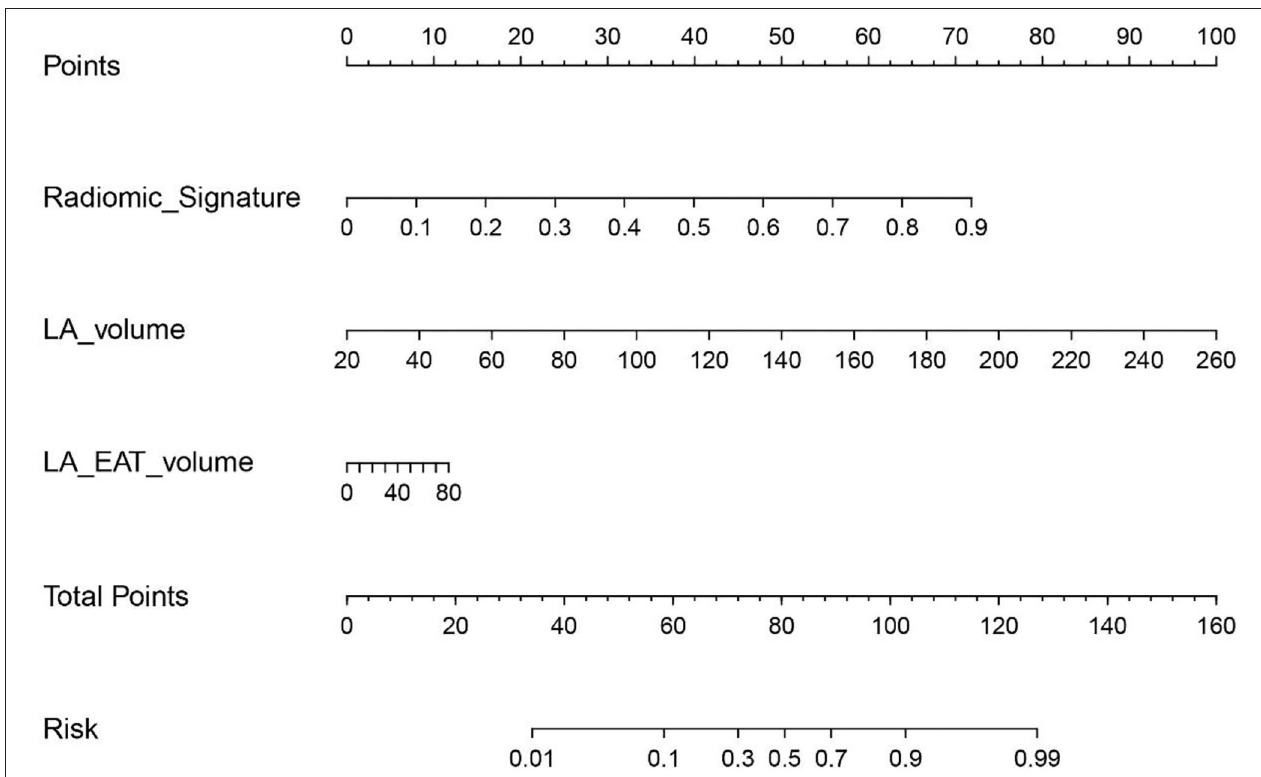
FIGURE 4 | The radiomics nomogram of a personalized predictive model.